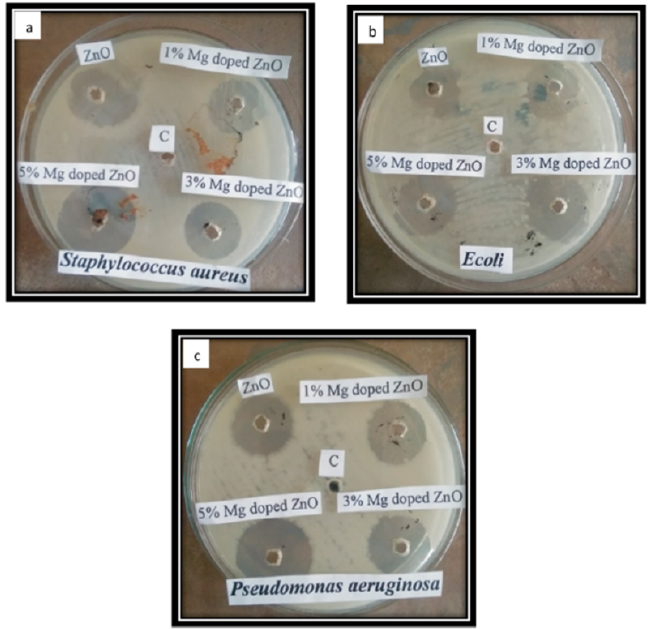
Figure 15. ( a – c ) Diameter of inhibition zones of Zn1 − xMgxO against bacteria pathogen. Re- ( a – c ) Diameter of inhibition zones of Zn1 − xMgxO against bacteria printed/adapted with permission from Ref. [188]. Copyright© 2022, Elsevier Ltd.